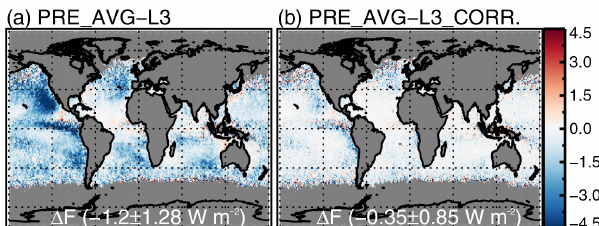
Figure 8. Extrinsic aerosol indirect radiative forcing computed us- ing AATSR observations over oceanic 1 ◦ × 1 ◦ regions during the pe- riod 2002–2012. Oceanic mean and standard deviation of the forc- ing ( (cid:49)F ) are given in parenthesis.